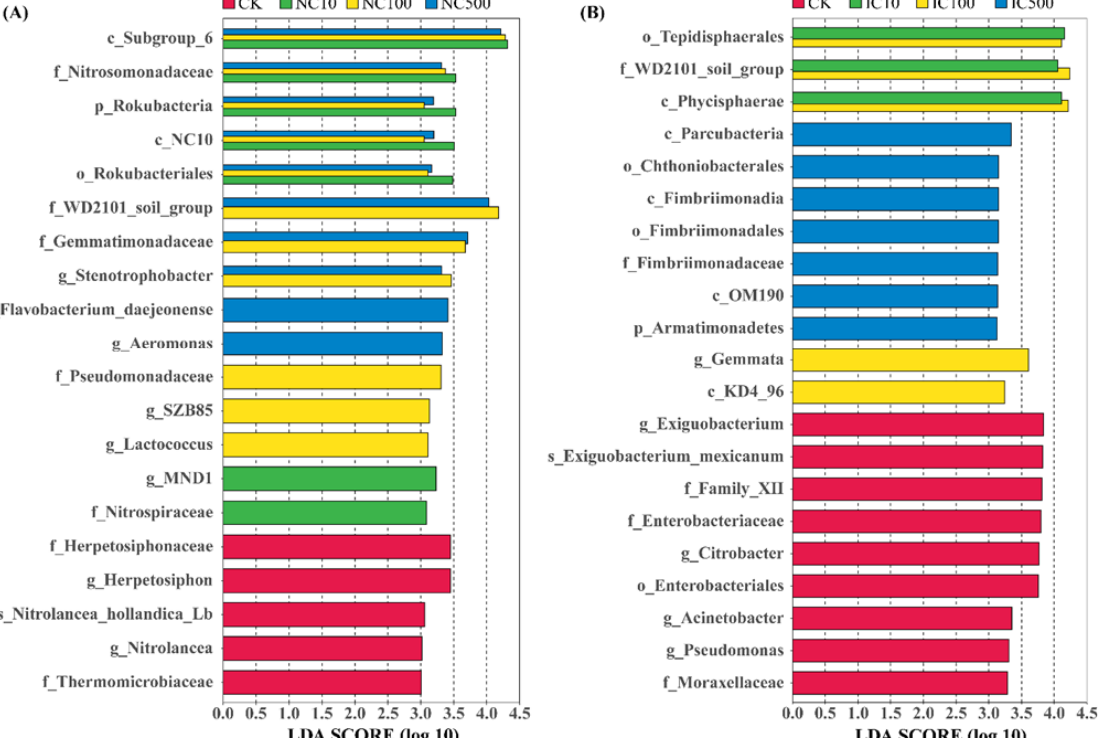
Table 3. Topological properties of bacterial co-occurrence networks under different treatments. Node